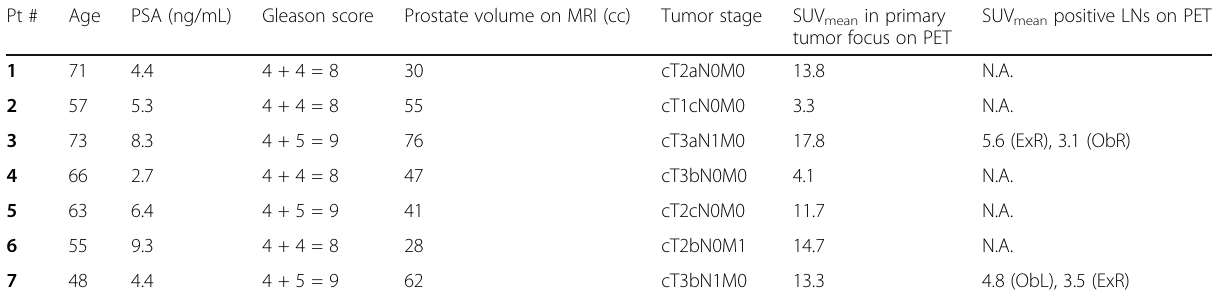
Table 1 Preoperative patient characteristics Pt #